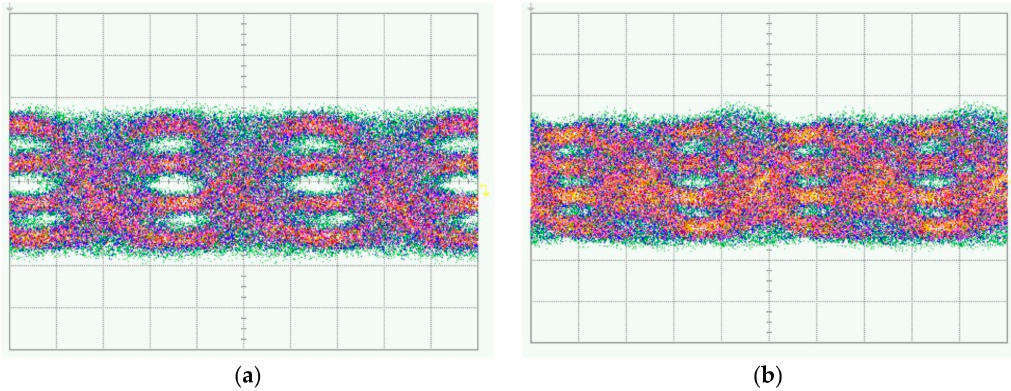
Figure 6. PAM-4 optical eye diagrams at ( a ) 32 and ( b ) 40 Gbaud in back-to-back